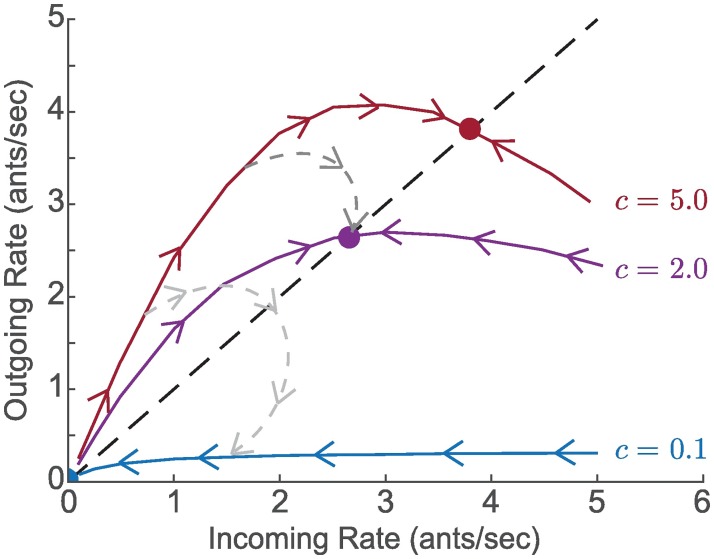
Model dynamics illustrating response of foraging rates to environmental conditions.Red, purple, and blue curves show closed-loop trajectories of rout(t) versus rin(t) for fixed volatility c equal to 5.0, 2.0, and 0.1, respectively. Initially, all available foragers are uninformed about the environment and have volatility cu = 5.0. The darker gray dashed curve shows the dynamics in the case when foragers exposed to the environment reduce their volatility to ci = 2.0, as might happen on a moderately hot and dry day. The lighter gray dashed curve shows the dynamics in the case when foragers exposed to the environment reduce their volatility to ci = 0.1, as might happen on a very hot and dry day.